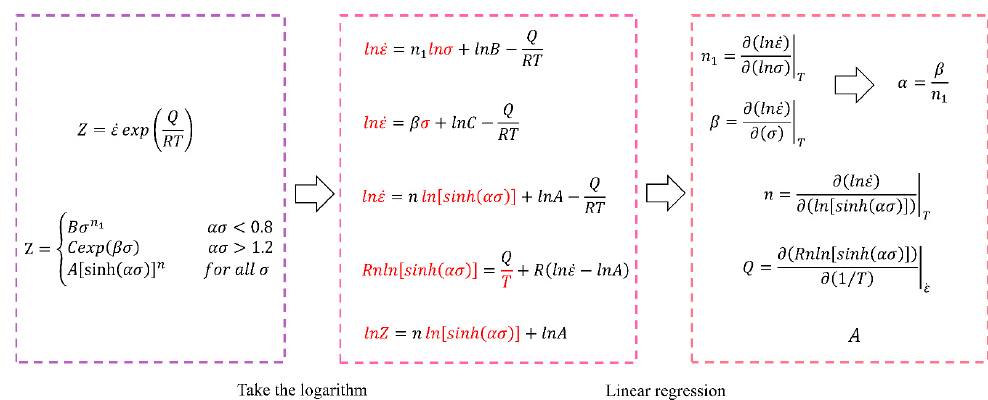
Figure 3. Flow chart of Arrhenius constitutive model parameters solving.